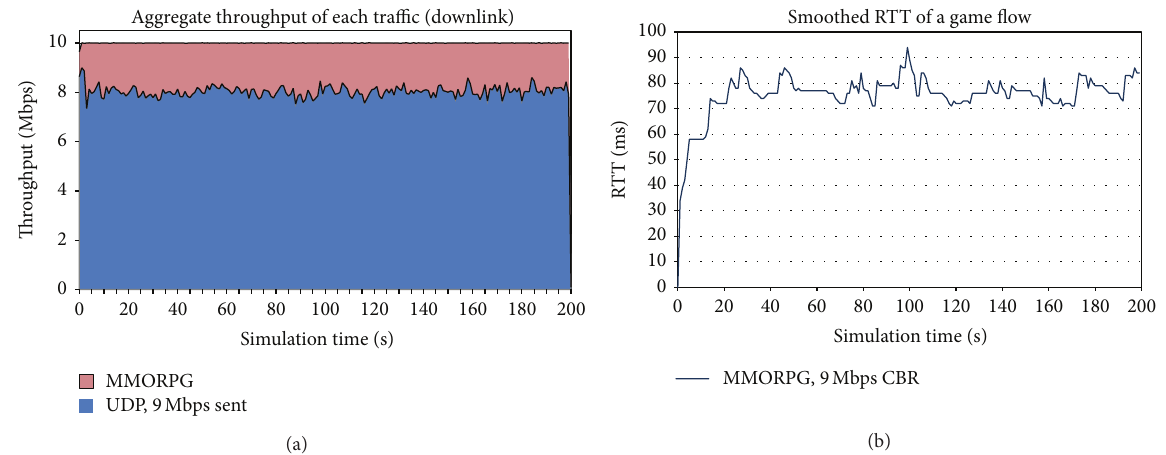
Figure 14: Coexistence of 100 MMORPG flows and 9Mbps of UDP CBR traffic: (a) received throughput in the downlink by each traffic and (b) smoothed RTT of one of the game flows.